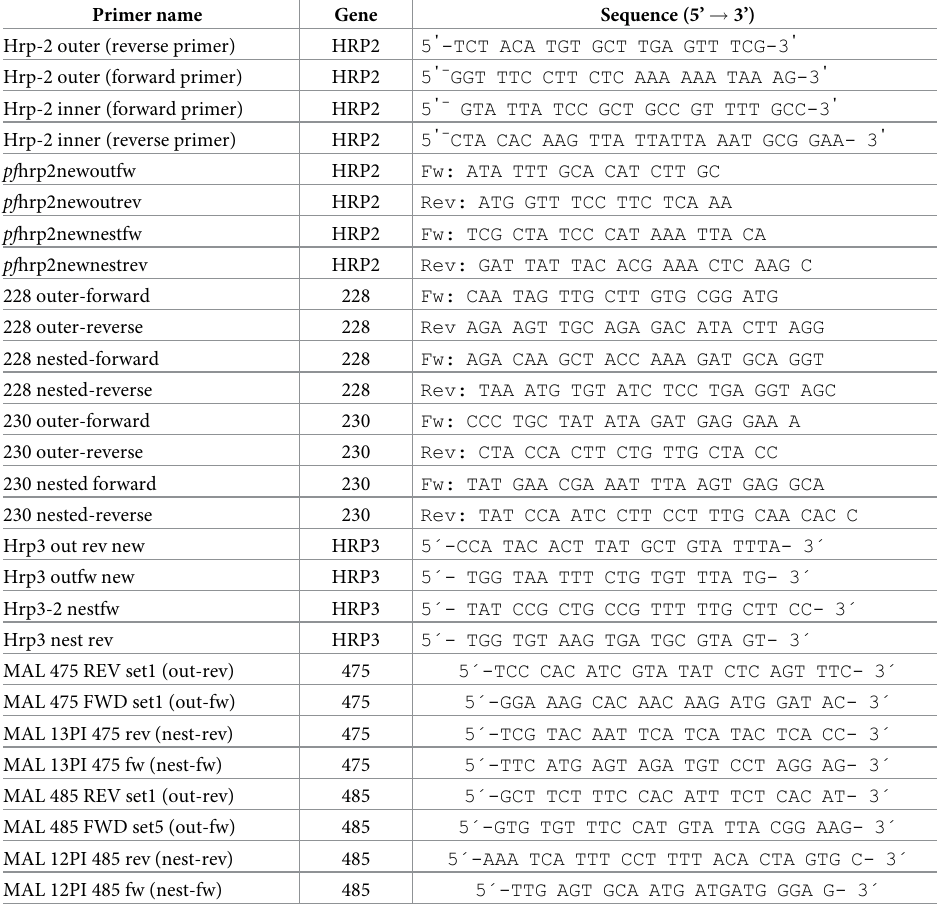
Table 1. Primers name and sequences used to amplify pfhrp 2/3 genes including the flanking